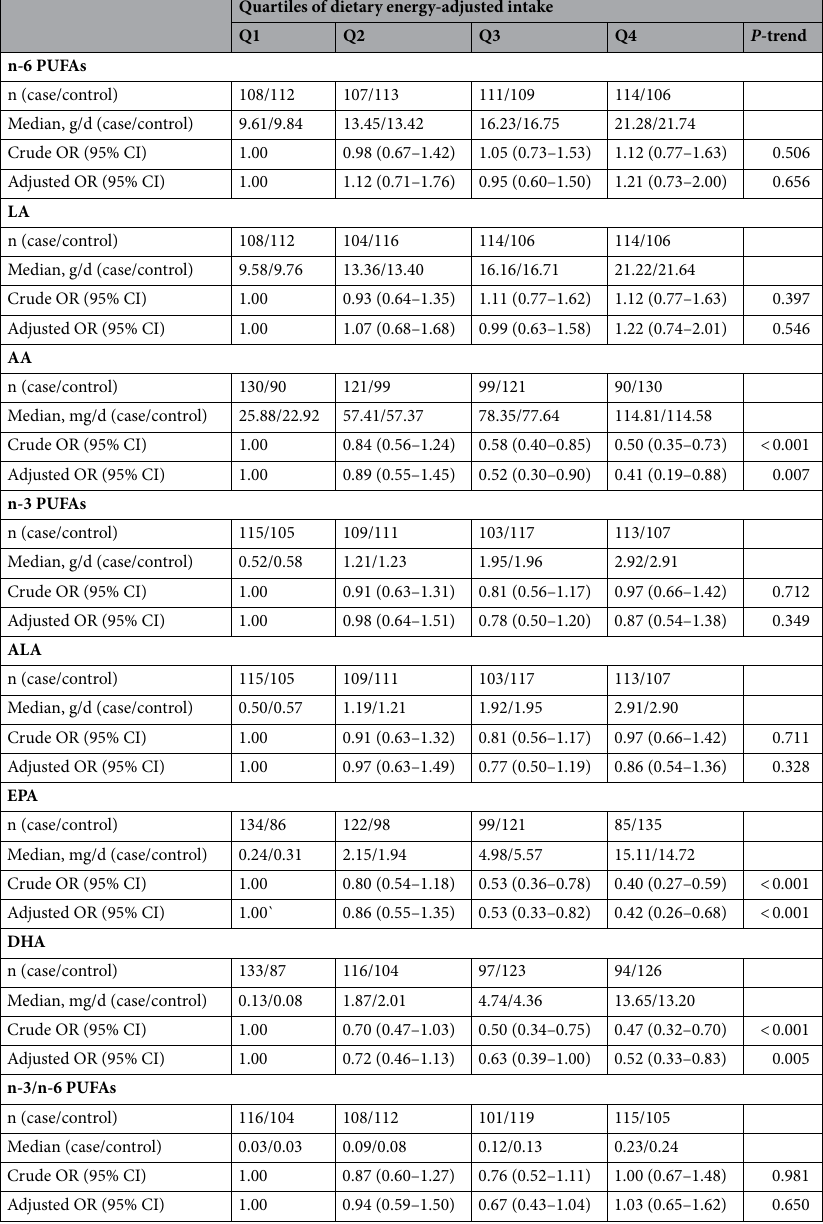
Table 4. Risk of preeclampsia during pregnancy according to quartiles of different types of polyunsaturated fatty acids. Abbreviation: PUFAs, polyunsaturated fatty acids; OR, odds ratio; LA, linoleic acid; AA, arachidonic acid; ALA, alpha-linolenic acid; EPA, eicosapentaenoic acid; DHA, docosahexaenoic acid. Crude and adjusted OR (95% CI): from conditional logistic model. Covariates includes age, gestational weeks, education level, household income, pre-pregnancy body mass index, alcohol drinking, passive smoking, use of multivitamin, use of folic acid supplement, daily energy intake, carbohydrate intake and total cholesterol intake by enter